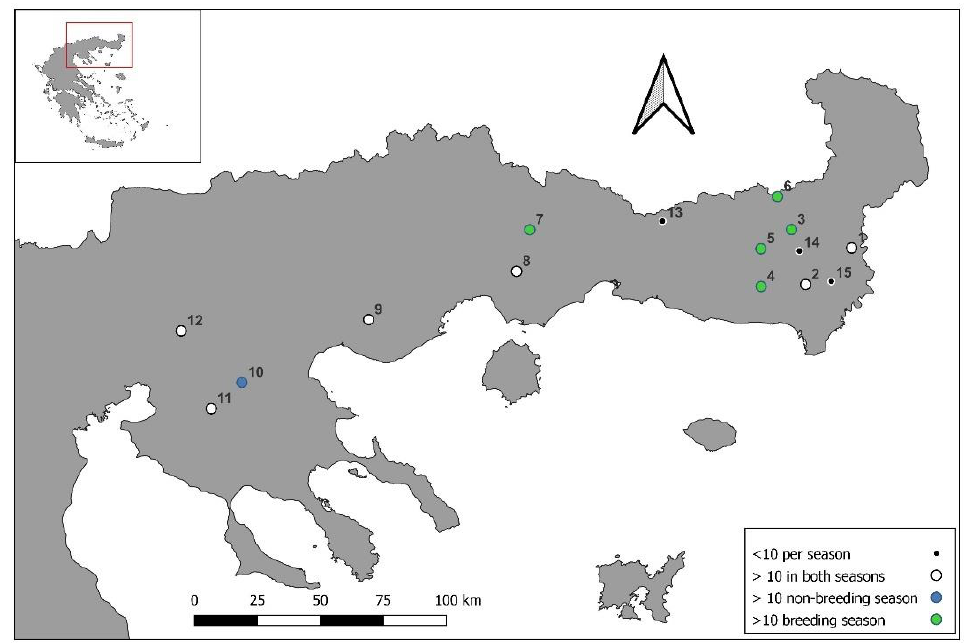
Figure 1. Sampled golden eagle territories in northern Greece. Only data from 11 and 7 territories with ≥ 10 prey items collected during the breeding and non-breeding seasons respectively were used in the analysis.